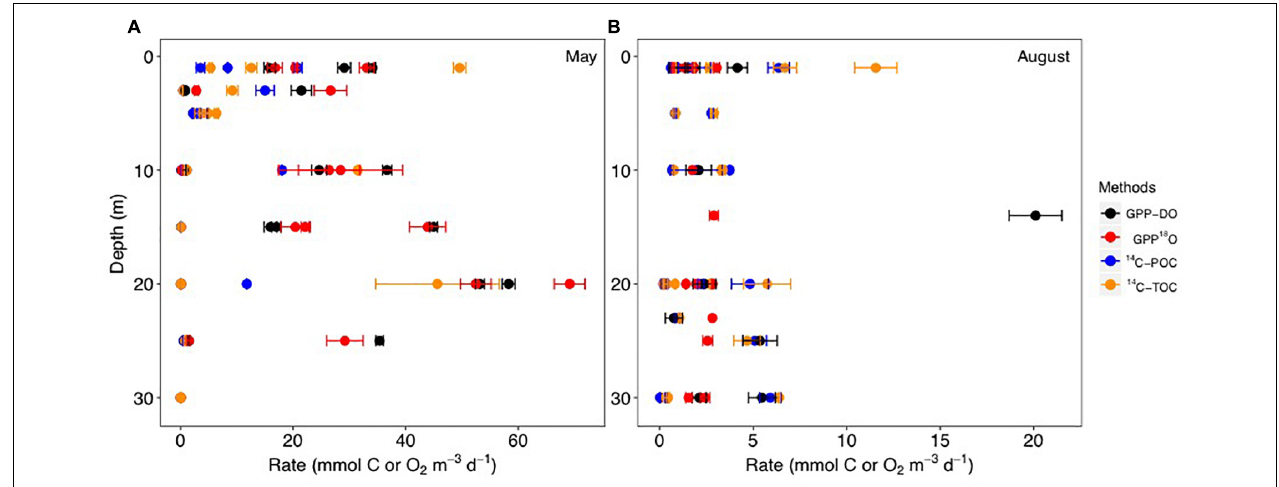
FIGURE 2 | Volumetric primary production (PP) rates compared in this study during the May (A) and August (B) 2014 cruises for the GPP-DO (in black), GPP- 18 O (in red), 14 C-POC (in blue), 14 C-TOC methods (in orange) in mmol C, or O 2 m − 3 d − 1 . Locations shown in Figure 1 . Symbols and error bars indicate average ± SE. Note change of rate scale.